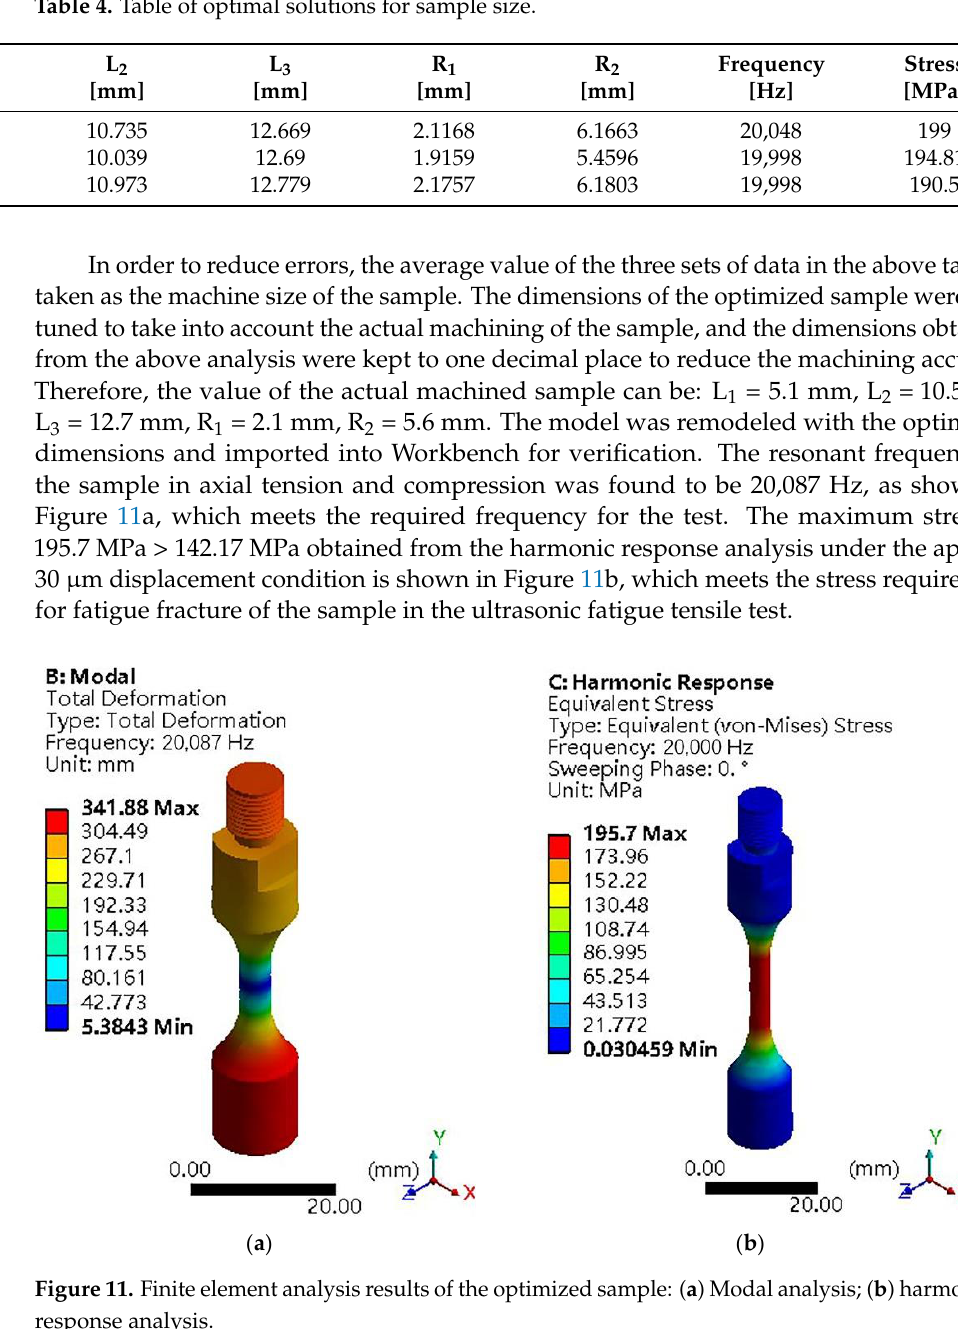
Table 4. Table of optimal solutions for sample size.